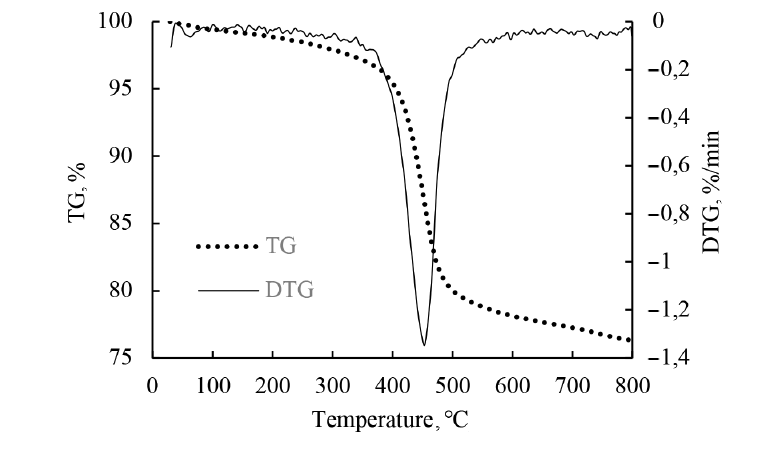
Fig. 3. TG and DTG curves of the oil shale